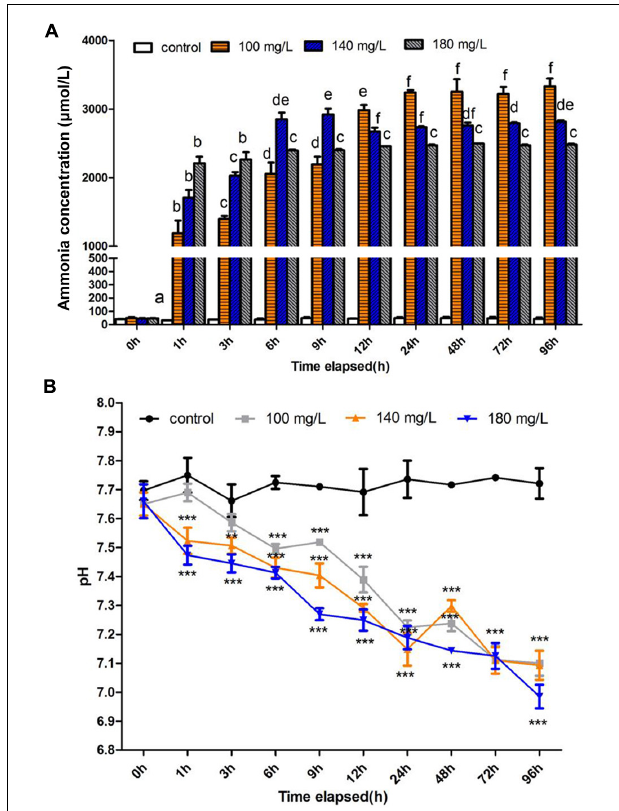
FIGURE 1 | Effects of ammonia concentration and pH in Sinonovacula constricta hemolymph under ammonia stress. (A) Ammonia concentration is mean ± SD ( n = 3). Data with different letters are significantly different in the same concentration group ( p < 0.05). (B) pH value is mean ± SD ( n = 3). Asterisk (*) indicates a significant difference between the exposed group and its respective control (* p < 0.05; ** p < 0.01; *** p <